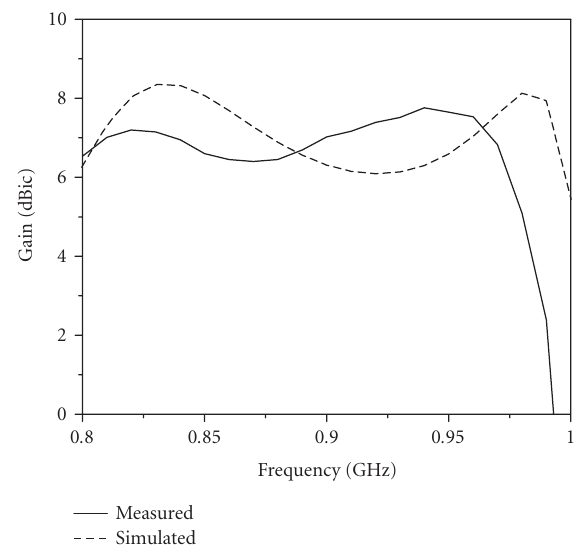
Figure 3: Measured and simulated gains of the proposed antenna.